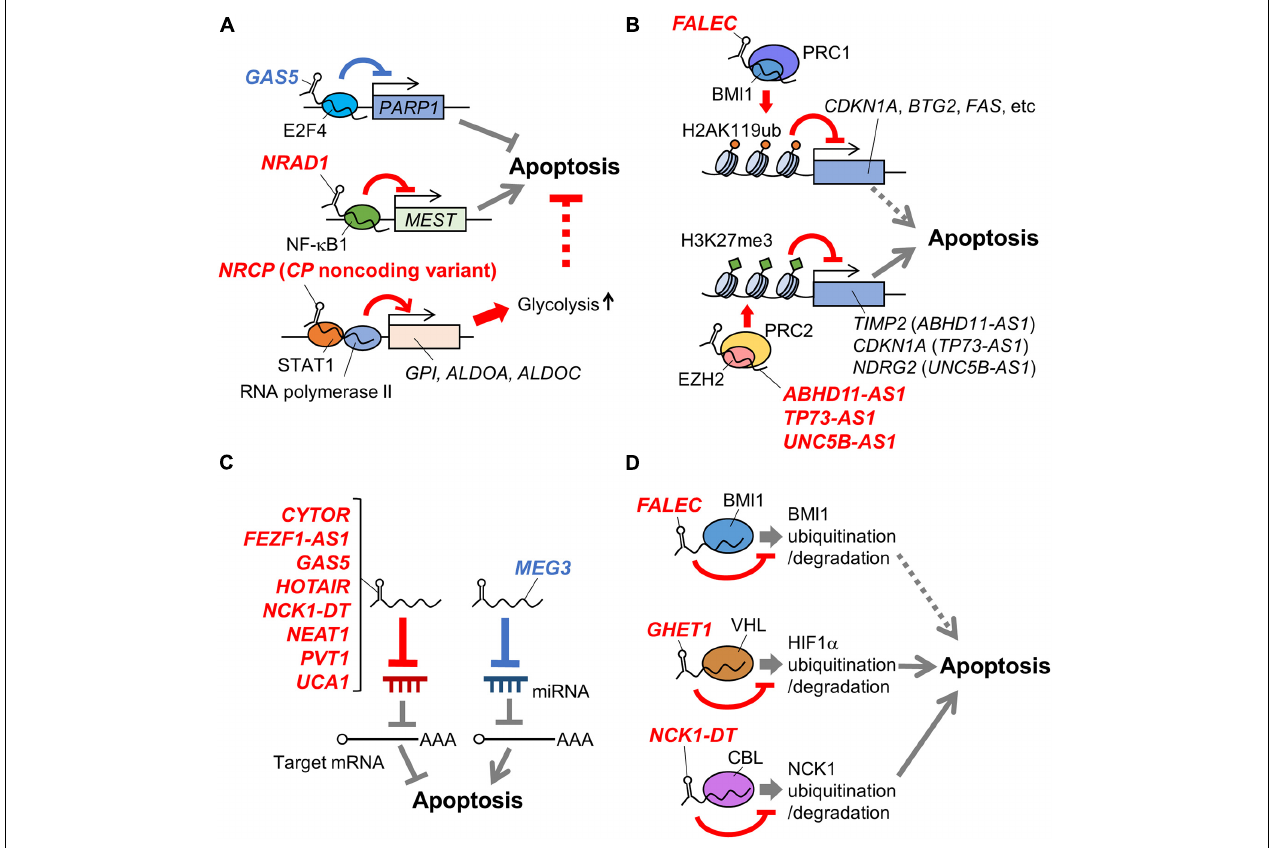
FIGURE 1 | Schematic representation of mechanisms of apoptosis-related lncRNAs in ovarian cancer. LncRNAs involved in apoptosis of ovarian cancer cells via regulating transcription factors (A) , histone modification complexes (B) , miRNAs (C) , and protein stability (D) are shown. Names of lncRNAs promoting and suppressing apoptosis are shown in blue and red, respectively. In addition, apoptosis-promotive or suppressive functions of lncRNAs are shown in blue or red lines, respectively. Potential apoptosis-associated biological pathways are shown in dotted lines. ABHD11-AS1, abhydrolase domain containing 11 antisense RNA 1; ALDOA, aldolase, fructose-bisphosphate A; ALDOC, aldolase, fructose-bisphosphate C ; BMI1, B lymphoma Mo-MLV insertion region 1 homolog; BTG2, B-cell translocation gene 2 ; CBL, casitas B-lineage lymphoma: CDKN1A, cyclin dependent kinase inhibitor 1A; CP, ceruloplasmin; CYTOR, cytoskeleton regulator RNA ; EZH2, enhancer of zeste homolog 2; FALEC, focally amplified long non-coding RNA in epithelial cancer; FEZF1-AS1, fasciculation and elongation protein zeta family zinc finger 1 antisense RNA 1; GAS5, growth arrest-specific 5; GHET1, gastric carcinoma high expressed transcript 1; GPI, glucose-6-phosphate isomerase ; H2AK119ub, the ubiquitination at the 119th lysine residue of the histone H2A; H3K27me3, the tri-methylation at the 27th lysine residue of the histone H3; HIF1 α , hypoxia-inducible factor 1 α ; HOTAIR, HOX transcript antisense RNA; MEG3, maternally expressed gene 3; MEST, mesoderm specific transcript ; NCK1, non-catalytic region of tyrosine kinase adaptor protein 1; NCK1-DT, NCK1 divergent transcript; NDRG2, n-myc downstream-regulated gene 2; NEAT1, nuclear enriched abundant transcript 1 ; NF- κ B1, nuclear factor kappa B subunit 1; NRAD1, non-coding RNA in the aldehyde dehydrogenase 1A pathway; NRCP, lncRNA ceruloplasmin; PARP1, poly(ADP-ribose) polymerase 1; PVT1, plasmacytoma variant translocation 1 ; STAT1, signal transducer and activator of transcription 1; TIMP2, tissue inhibitor of metalloproteinase 2; TP73-AS1, tumor protein p73 antisense RNA 1; UCA1, urothelial carcinoma associated 1; UNC5B-AS1, uncoordinated 5 netrin receptor B antisense RNA 1